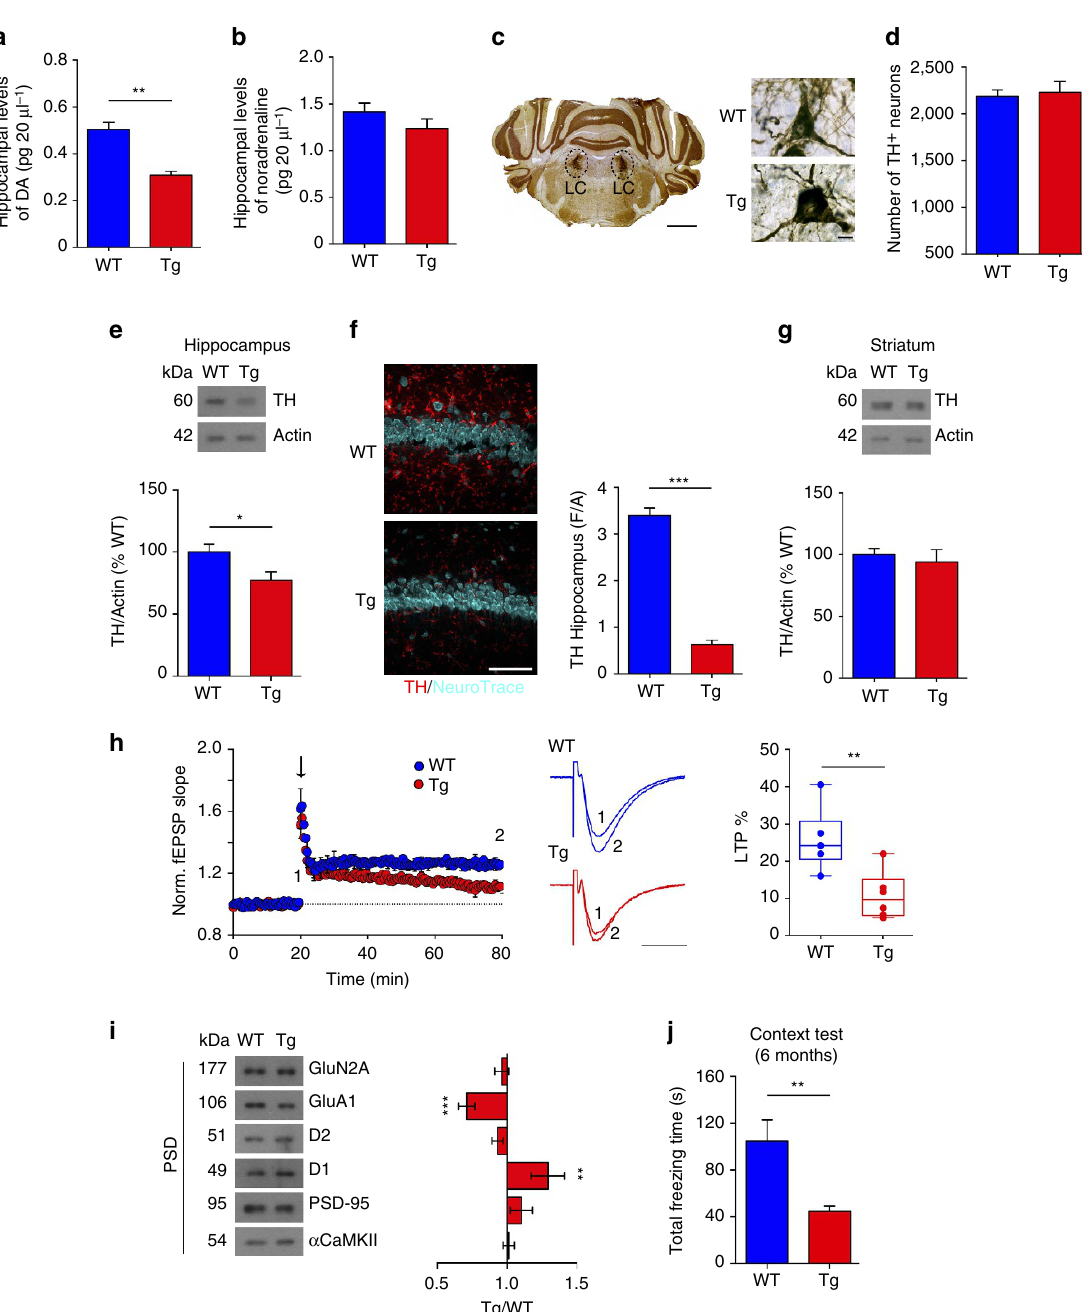
Figure 4 | Six-month-old Tg2576 mice show reduced DA outflow in the hippocampus and synaptic plasticity and memory deficits. ( a , b ) In vivo microdialysis for DA ( a ) and noradrenaline ( b ) in the hippocampus of 6-month-old WT ( n ¼ 6) and Tg2576 ( n ¼ 5) mice ( a : F 1,9 ¼ 5.138, ** P ¼ 0.009; ( b ): F 1,9 ¼ 0.688, P ¼ 0.428, one-way ANOVA). ( c ) TH immunoreactivity (brown) in the LC (scale bar, 500 m m) of a 6-month-old WTmouse and images of TH þ neurons in WTand Tg2576 mice (scale bar, 10 m m). ( d ) Quantification of LC TH þ neurons in 6-month-old mice ( n ¼ 6 per genotype; 9 sections per animal). ( e ) Immunoblots of total hippocampal TH protein from 6-month-old mice ( n ¼ 6 per genotype) and densitometric quantification of changes in grey values (two-tailed unpaired t -test * P ¼ 0.037). ( f ) TH/NeuroTrace double-labelling in CA1 sections (scale bar, 50 m m) and TH densitometric levels in 6-month-old mice ( n ¼ 3 per genotype, 4 sections per animal; two-tailed unpaired t -test *** P ¼ 5.00 (cid:3) 10 (cid:2) 5 ). ( g ) As in e showing total TH protein from the dorsal striatum ( n ¼ 6 mice per genotype). ( h ) Normalized CA3-to-CA1 fEPSP mean slope ( ± s.e.m. every 2min) recorded from the CA1 dendritic region in slices from 6-month-old mice. A high frequency conditioning train was delivered (arrow) following a 20min baseline. Traces (scale bars, 100 m V, 10ms) are fEPSPs recorded during baseline (1) and 1h after the train (2). The plot indicates the degree of potentiation at 55–60min after the train (WT: n ¼ 6 slices from 4 mice; Tg2576: n ¼ 6 slices from 5 mice; two-tailed unpaired t -test ** P ¼ 0.006). ( i ) Immunoblots of hippocampal PSD proteins from 6-month-old mice ( n ¼ 8 per genotype), probed with the indicated antibodies, and densitometric quantification of changes in grey values expressed as mean ratio of Tg/WT (two-tailed unpaired t -test: D1, ** P ¼ 0.002; GluA1, *** P ¼ 0.001). ( j ) Total freezing time during the CFC context test (6 mice per genotype; two-tailed unpaired t -test ** P ¼ 0.009). Except from the box-and-whisker plot in h , values represent mean ±